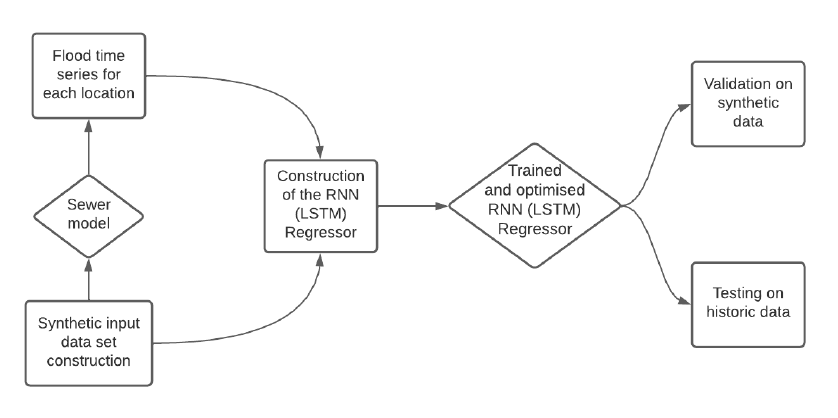
Figure 1. Flow chart of the steps taken in the present research to set up an LSTM that is able to predict inundation volumes at manhole locations.